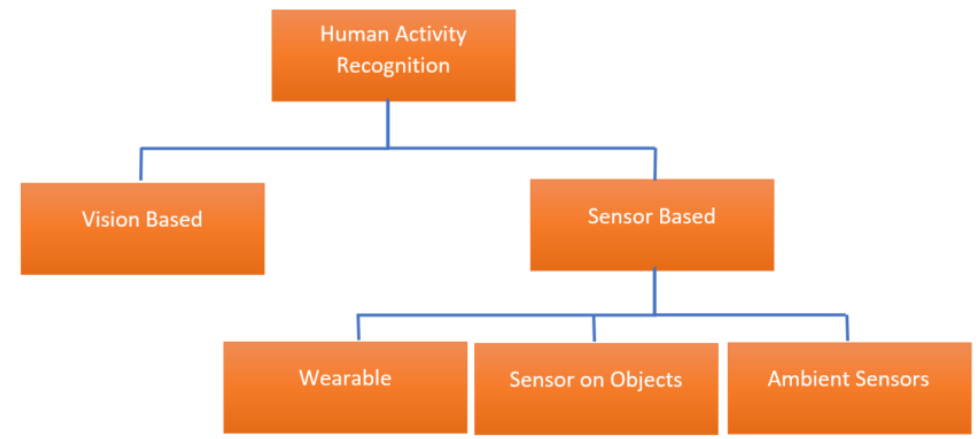
Figure 1. Human Activity Recognition